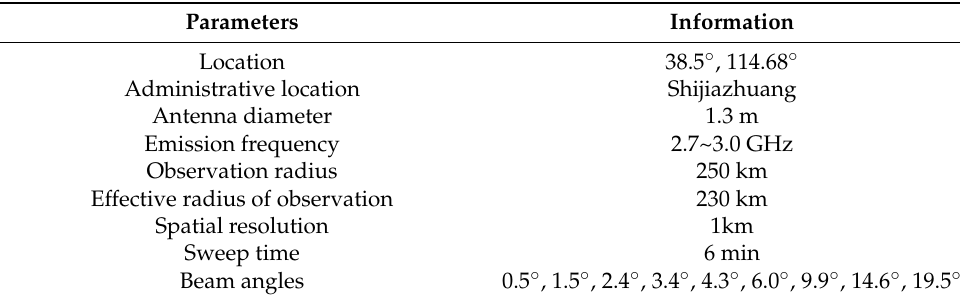
Table 4. Basic parameters of S-band radar in